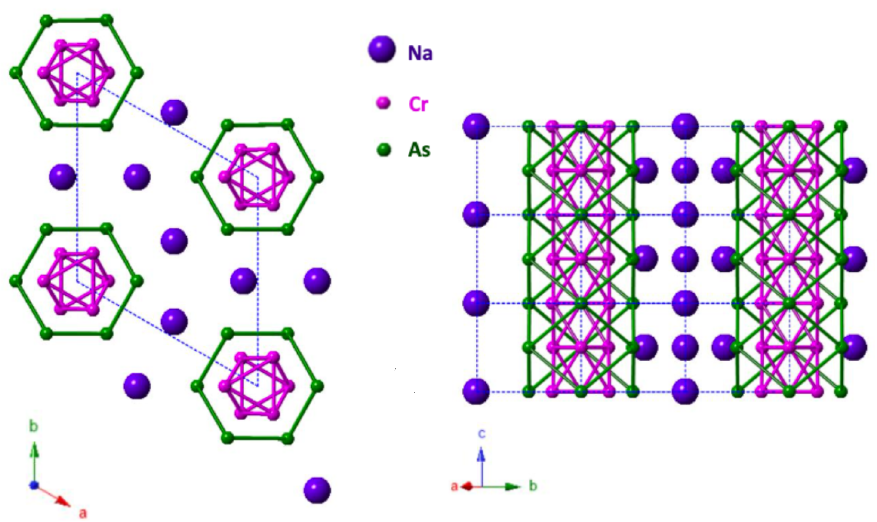
Figure 1. (Color online) ( Left panel) The hexagonal lattice structure of Na 2 Cr 3 As 3 . ( Right panel) A 2 Cr 3 As 3 has a typical Q1D structure, which is derived from 1D CrAs chains that crystallize in the form of double-wall subnanotubes, with the alkali metal ions residing in the CrAs chains’